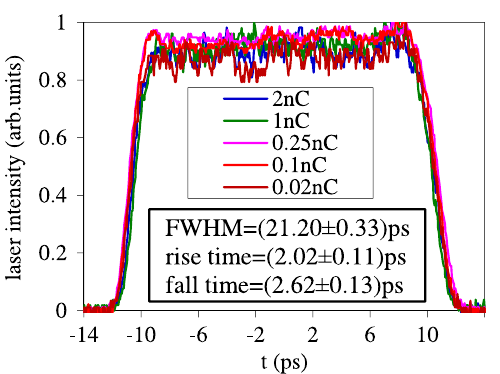
FIG. 5. Photocathode laser pulse temporal profiles measured with the OSS. The different curves correspond to the laser pulse shape detected while the best emittance for the given bunch charge was measured. The statistical analysis of flattop distribu- tion fits (FWHM, rise and fall time) to the measured profiles yields the number given in the plot.